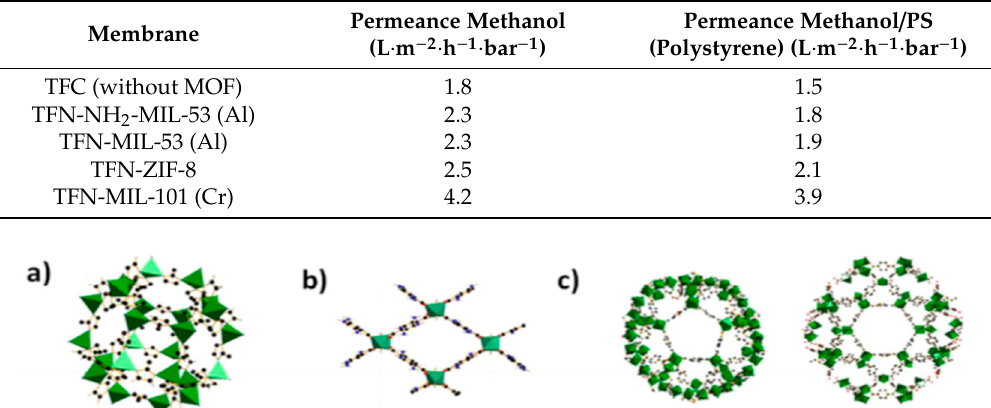
# The values in parentheses are subjected to MOF loading in %. Table 3. Organic Solvent nanofiltration ( OSN) results of TFN membranes for MeOH at 30 ° C and 30 bar. (The values given are an average of 3-4 different membranes); Reproduced with permission from Table 3. Organic Solvent nanofiltration (OSN) results of TFN membranes for MeOH at 30 ◦ C and 30 bar. [63]. (The values given are an average of 3–4 di ff erent membranes); Reproduced with permission from [63].